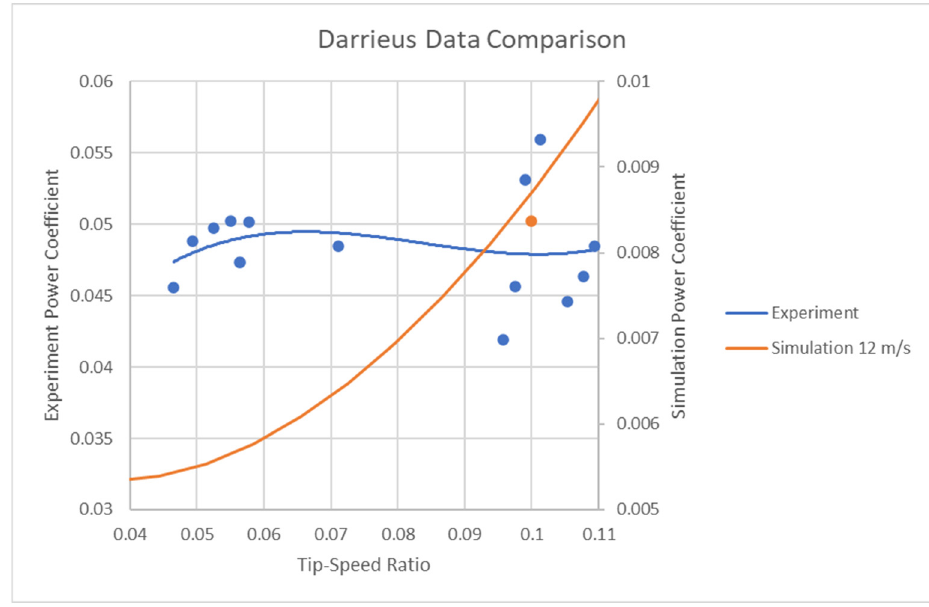
Figure 20. Unaltered Darrieus turbine data comparison.